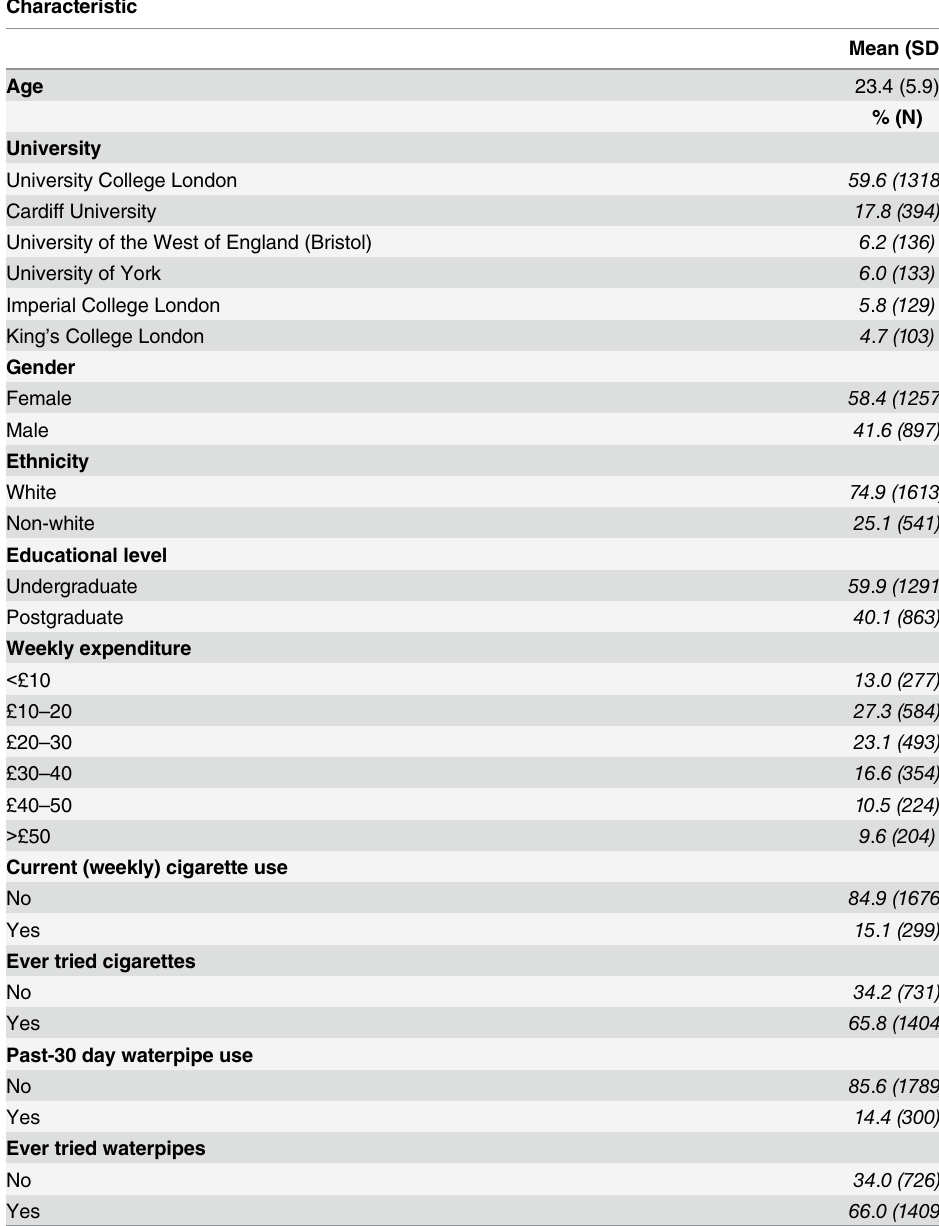
Table 1. Participant characteristics (N =